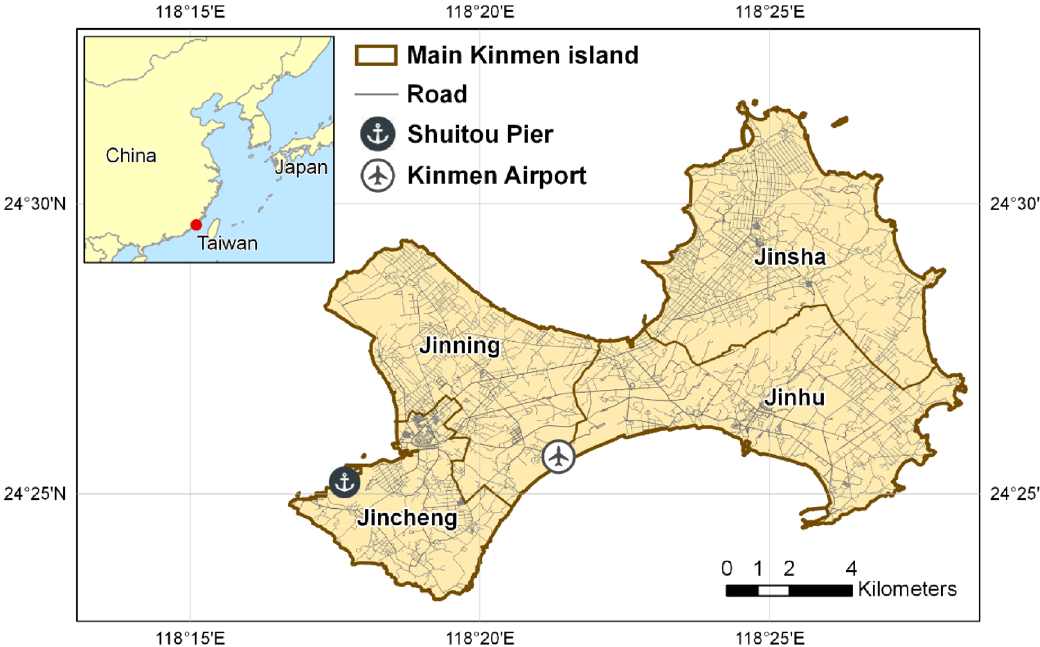
Figure 1. The location of four townships in the main Kinmen island, Taiwan. The red point in the index map is Kinman. This map is generated by ArcGIS 10.7 19